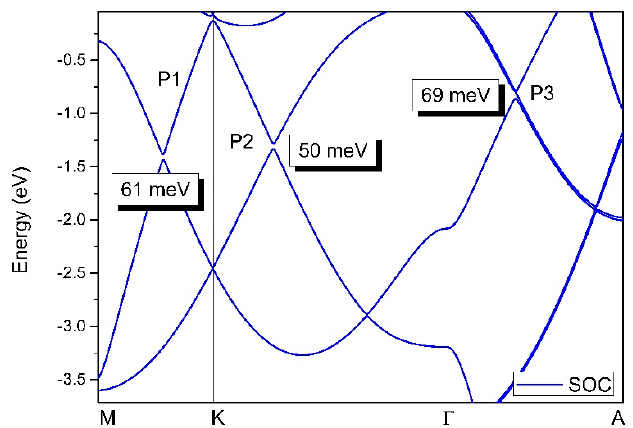
Figure 9. Band structure of CrB 2 along the M–K– Γ paths calculated using a GGA. The spin–orbit coupling effect was considered.